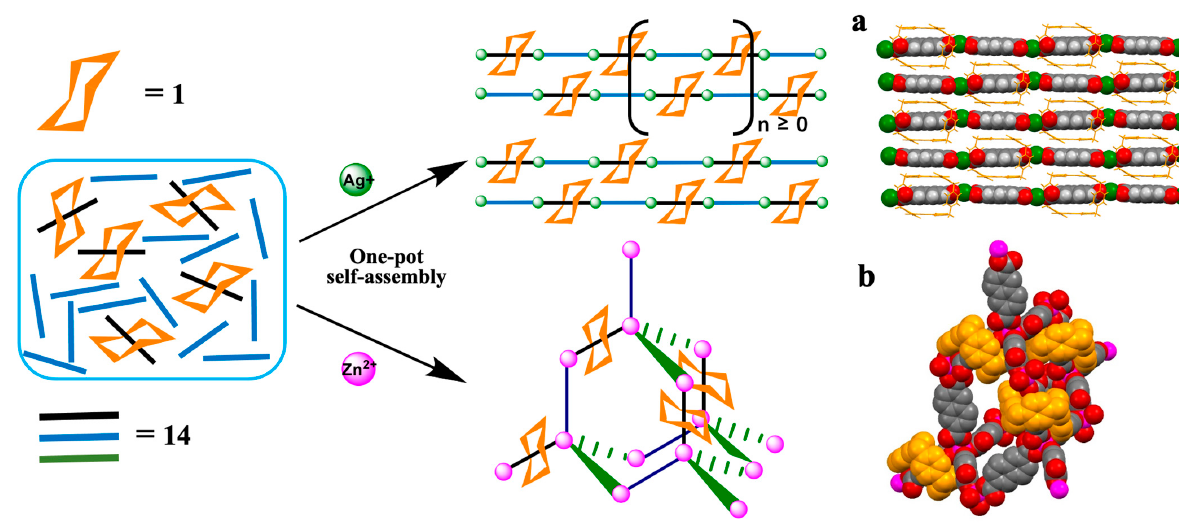
Figure 5. Schematic representations and structures of the 2D array made up of 1D polyrotaxane subunits and the 3D metal–organic rotaxane frameworks (MORFs) formed from the TxSB 1 and the 2,6-naphthalene dicarboxylic dianion. Note: Compound numbers are provided in Table 1. Modified with permission from a figure that first appeared in ref. [52]. Copyright 2011 The Royal Society of Chemistry.